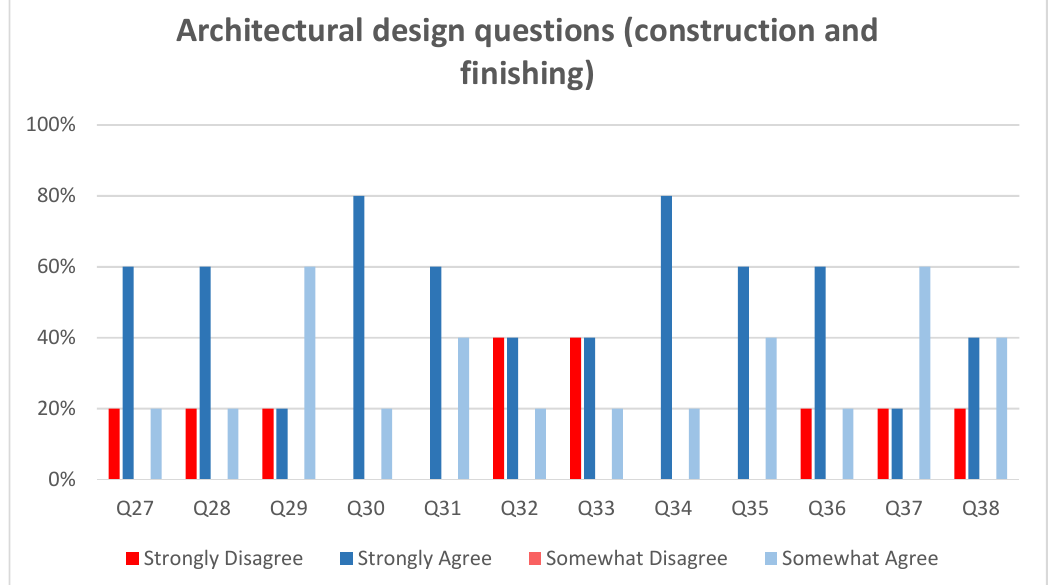
Figure 10. Results of the questions on construction and finishing.